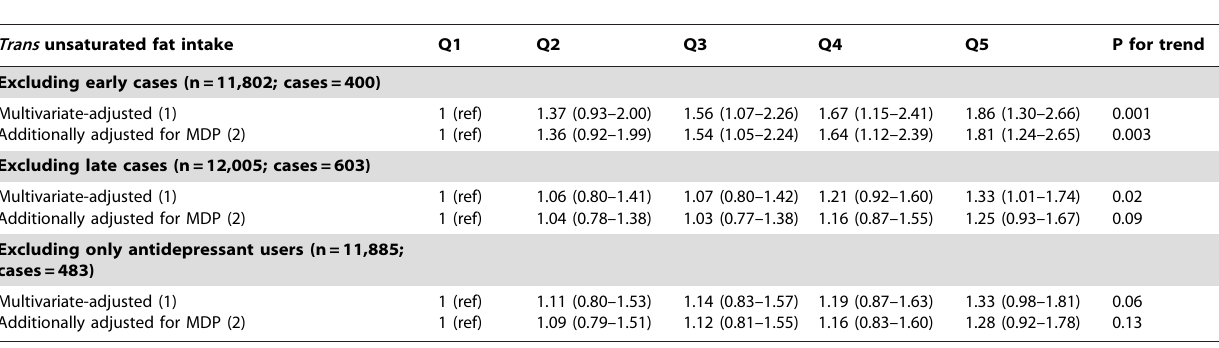
Table 3. Sensitivity analysis for the association between the several dietary fats intake (quintiles) and depression.*